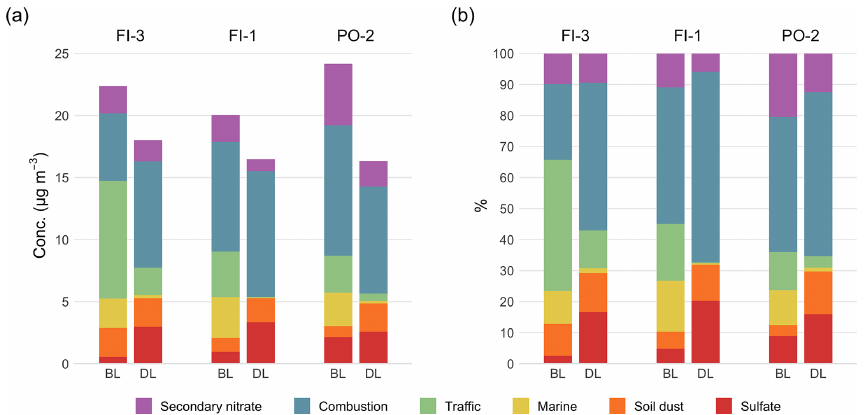
Figure 10. Comparison between the two periods for the (a) concentrations and (b) percentages of the sources obtained from the PMF analysis for each of the three